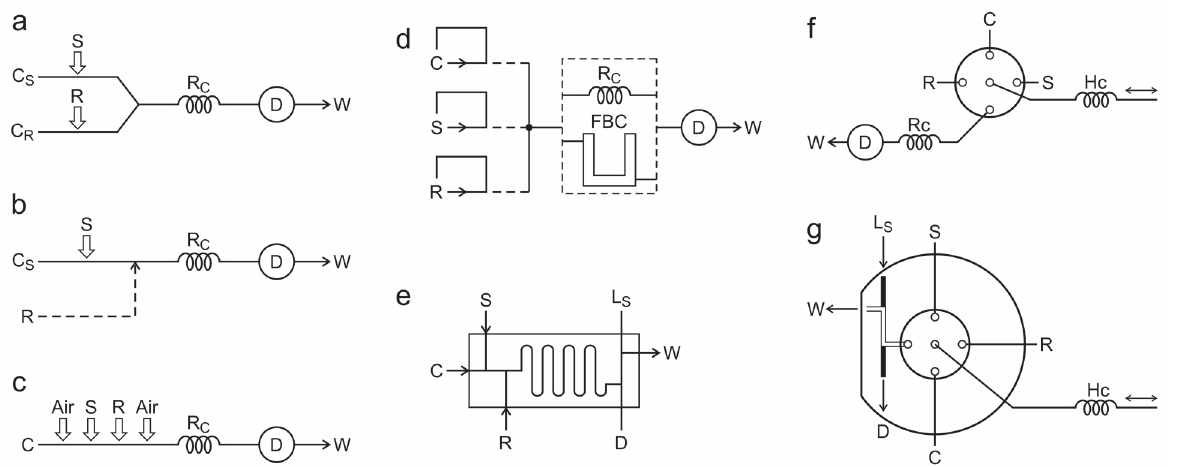
Figure 2 – Schematic representation of some environmental friendly flow modalities presented by Brazilian authors: ( a ) merging zones; ( b ) intermittent flows; ( c ) monosegmented flow analysis; ( d ) multicommutation and multi-pumping (with dispersion in Rc) and flow-batch analysis (mixing in FBC); ( e ) micro-flow analyzers; ( f ) sequential injection analysis and ( g ) lab-on-valve. C, Ci- carriers; S-sample; R-reagent solution; Rc-coiled reactor; Hc-holding coil; FBC-flow-batch chamber; D-detector; LS-light source; W-waste